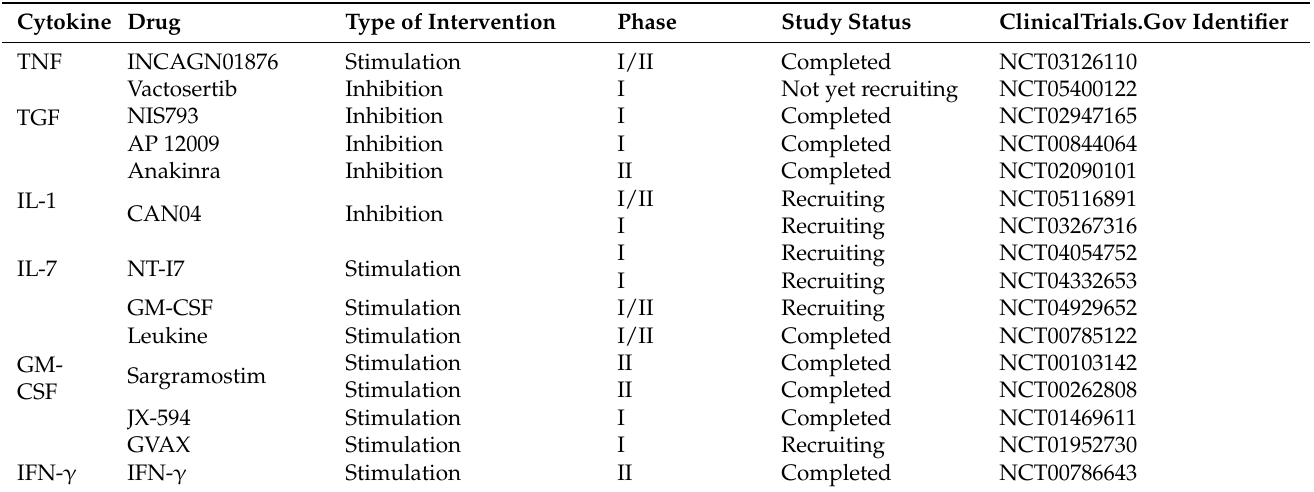
Table 1. Recent studies targeting cytokine signaling in colorectal cancer. Cytokine Drug Type of Intervention Phase Study Status ClinicalTrials.Gov